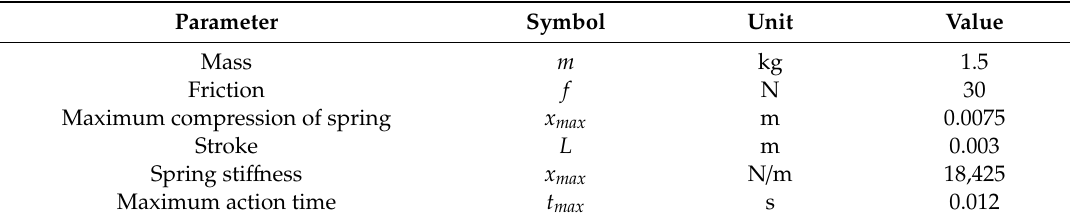
Table 2. Actuator